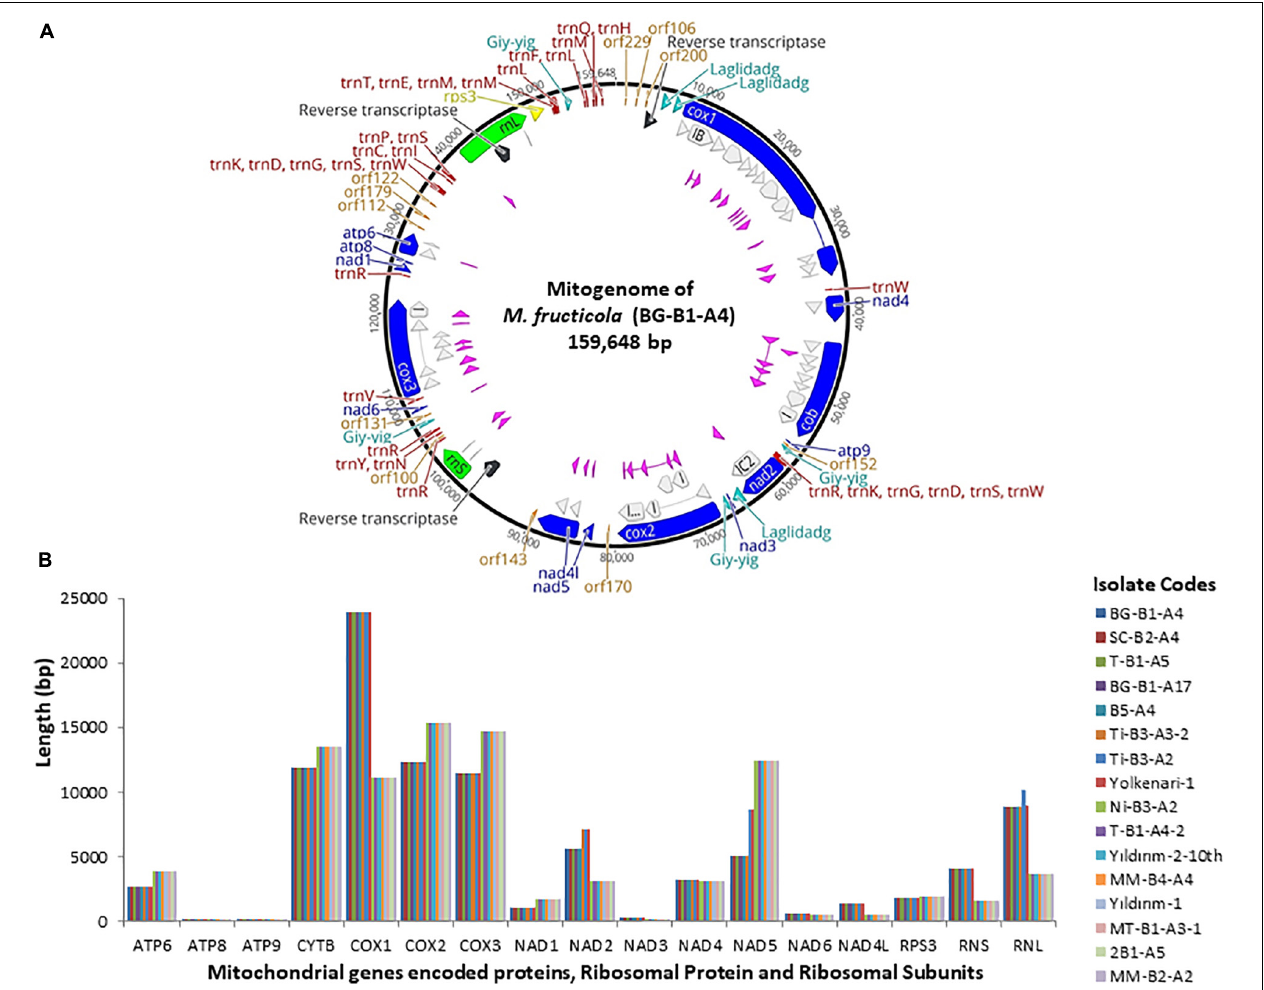
FIGURE 1 | (A) Annotated reference circular mitogenomes of M. fructicola, showing core conserved protein-coding genes (blue) with introns-encoded homing endonucleases (pink and turquoise), reverse transcriptase (black), orf (orange), two ribosomal subunits (green), rps3 (yellow), introns (gray), and tRNAs (red). (B) Length variation of 14 protein-coding genes, two ribosomal subunits, and rps3 among 16 mitogenomes of Monilinia